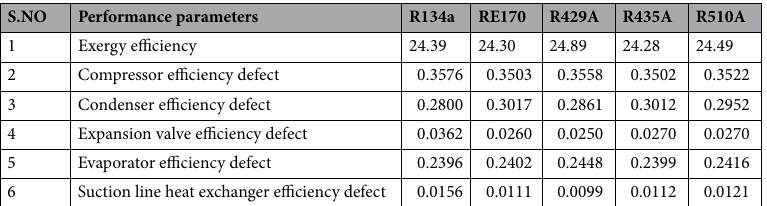
Table 2. Observations of performance parameters in VCR system. Tcod = 45 °C, T evap = − 10 °C, Temperature of superheat = 10 °C and Temperature of sub cool = 5 °C.